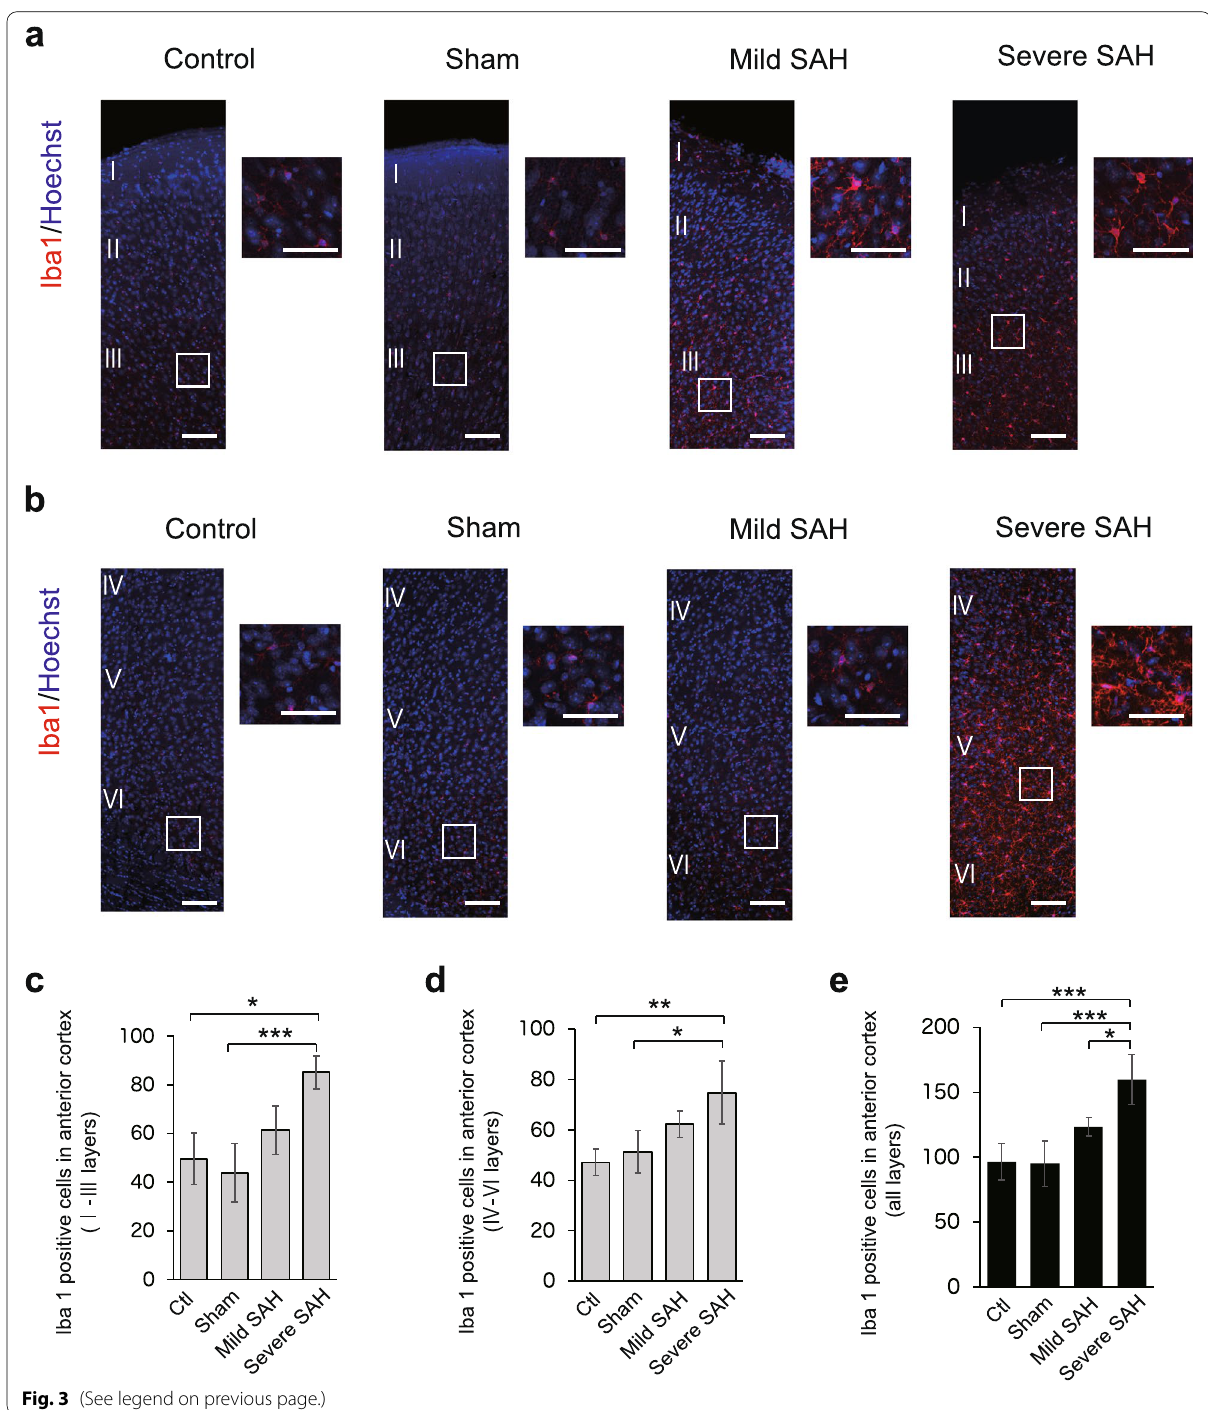
Fig. 3 (See legend on previous